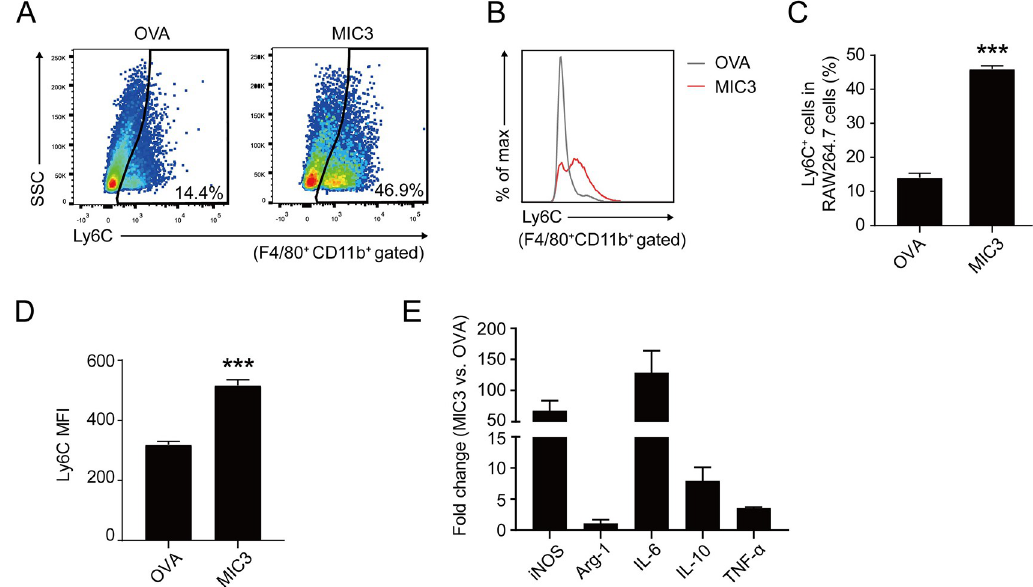
Fig 2. The expression levels of inflammation markers in RAW264.7 cells after 24 h-treatment of MIC3. (A) Ly6C expression in RAW264.7 cells. After 24 h-treatment of 4 μ g/ml OVA and 4 μ g/ml MIC3, Ly6C expression on F4/80 + CD11b + gated RAW264.7 cells were evaluated by flow cytometry. One representative of three independent experiments is shown. (B) Overlay of representative histograms showing Ly6C expression in RAW264.7 cells treated with 4 μ g/ml OVA and 4 μ g/ml MIC3. (C) The percentage of Ly6C + cells in F4/80 + CD11b + gated RAW264.7 cells. Data are expressed as the means ± S.D. (n = 3 independent experiments). Significance was determined by the two-tailed Student’s t -test. ��� , P < 0.001. (D) The mean fluorescence intensity (MFI) of Ly6C expression in F4/80 + CD11b + gated RAW264.7 cells. Data are expressed as the means ± S.D. of three independent samples for each group. Significance was determined by the two-tailed Student’s t -test. ��� , P < 0.001. (E) The mRNA levels of inflammatory genes after 24 h-treatment of 4 μ g/ml MIC3 in RAW264.7 cells. Data are expressed as the means ± S.D. of four independent samples for each group.